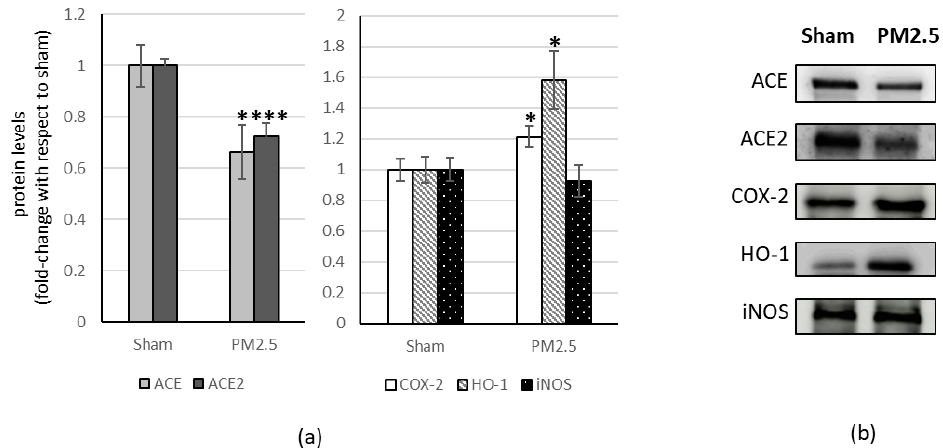
Figure 3. Immunoblotting analysis of ACE, ACE2, and COX-2, HO-1, iNOS in the heart. ( a ) Proteins were evaluated following cell subacute treatment with PM2.5. Each protein has been normalized with respect to the total amount of proteins detected by Ponceau staining, allowing a straightforward correction for lane-to-lane variation. Each protein has been normalized onto the respective sham (n = 5). Values represent Mean ± SE. * p < 0.05 versus sham, *** p < 0.001 versus sham ( b ) Corresponding representative immuno-blotting images. Table 1. ACE/ACE2 ratio in the various organs analyzed.